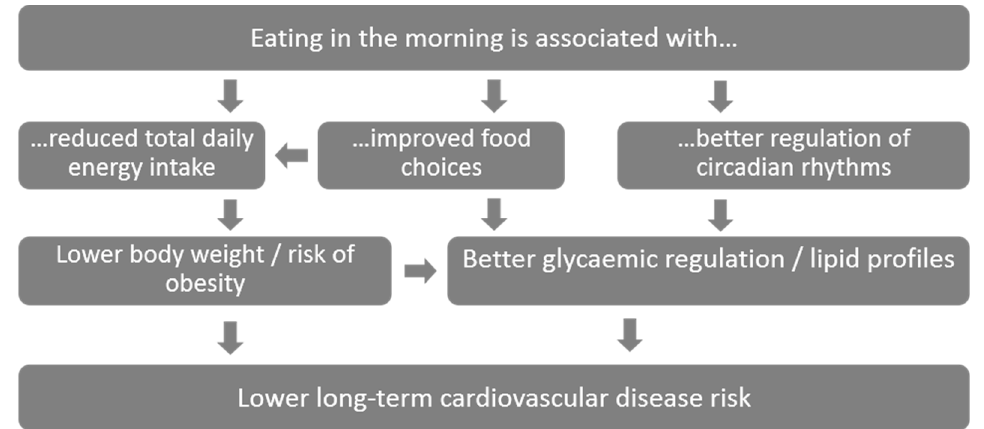
Figure 1. Hypothesized mechanisms for associations of breakfast with cardiovascular disease risk .